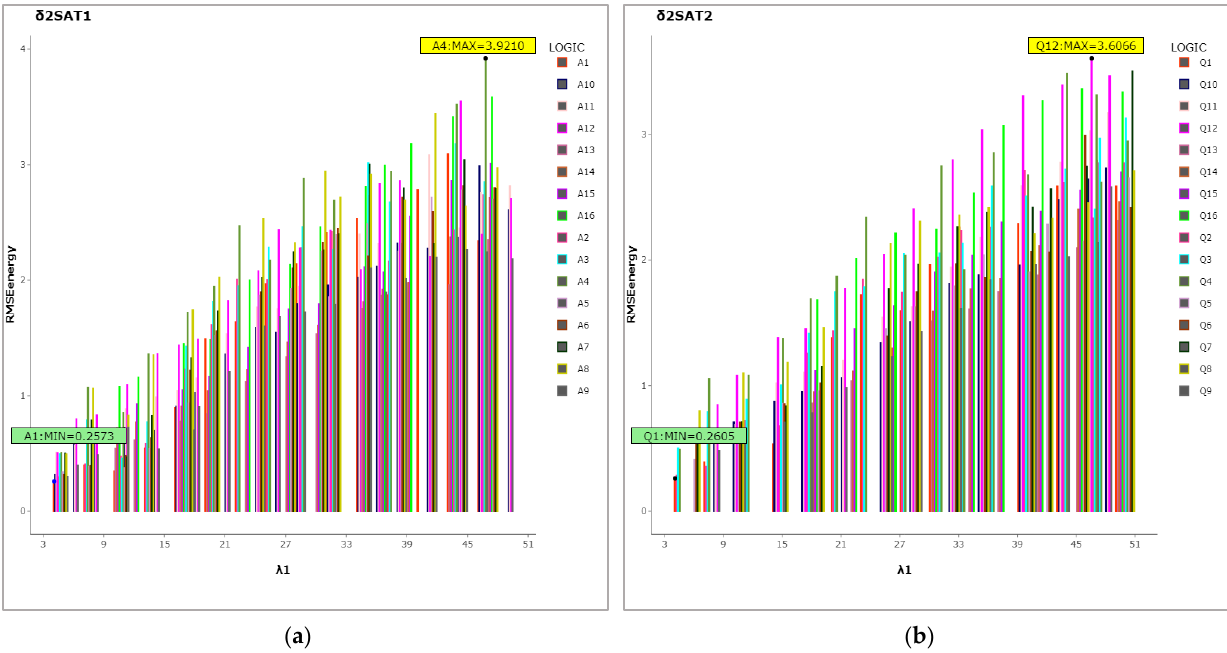
Figure 11. RMSE energy column representation for models in both types of logic ( a ) 1 2 SAT   ,( b ) Figure 11. RMSEenergy column representation for models in both types of logic ( a ) δ 1 2 SAT ρ , 2 SAT   . ( b ) δ 2 2 SAT ρ . 2 Table 15. Maximum and minimum RMSEenergy results for models in both type of logic δ 1 2 SAT ρ , δ 2 2 SAT ρ details by Wilcoxon test for